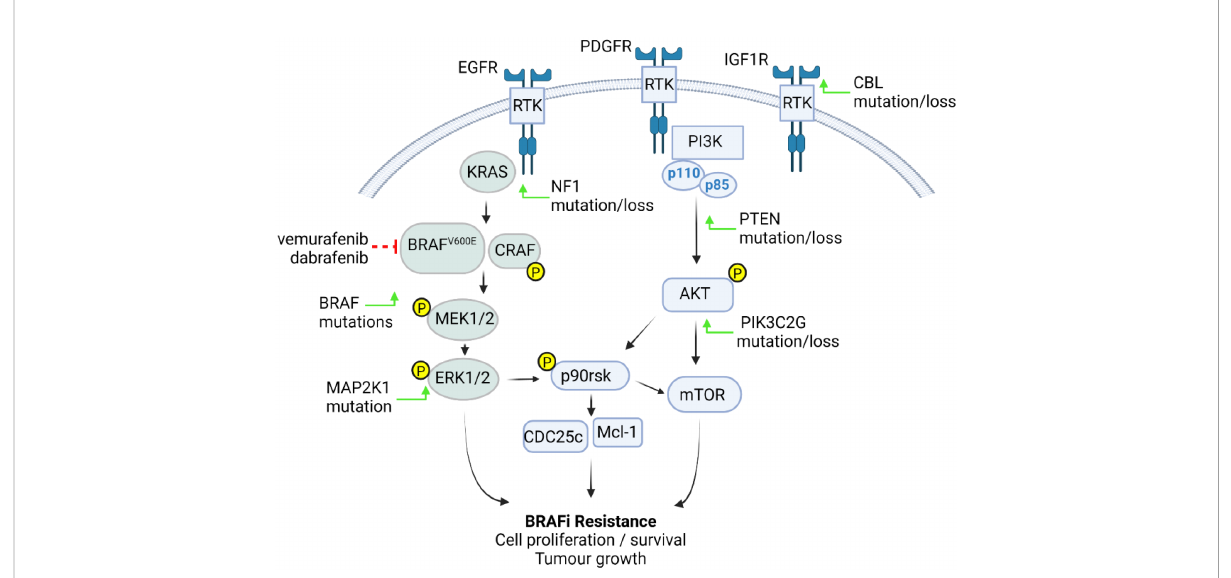
FIGURE 1 BRAF V600E pHGG resistance mechanisms. Tumour cells become resistant to BRAFi through increased activation of the RAS-RAF- MEK-ERK or PI3K-AKT pathways. These events are driven by upregulation or activation of receptor tyrosine kinases (RTK) such as EGFR, PDGFR b and IGF1R through either BRAF mutations or CBL, NF1, PTEN, MAP2K1, or PIK3C2G mutation or loss (green arrows), resulting in pathway phosphorylation and activation of downstream p90rsk, Mcl-1 and cell cycle components, leading increased cell proliferation, survival and tumour growth ( fi gure created with